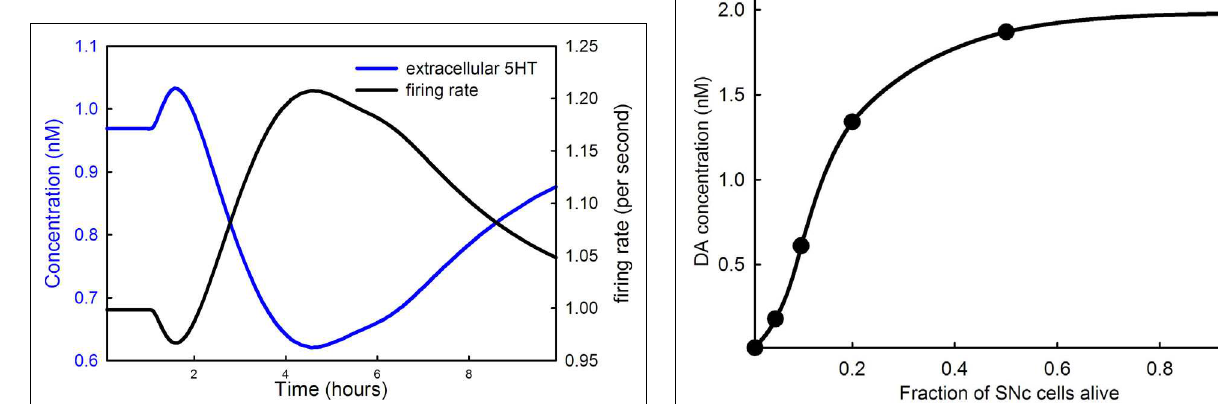
FIGURE 6 | Extracellular DA concentration as a function of the fraction of SNc cells alive. The curve shows that the extracellular DA concentration in the striatum does not fall appreciably until 80% or more of the SNc cells have